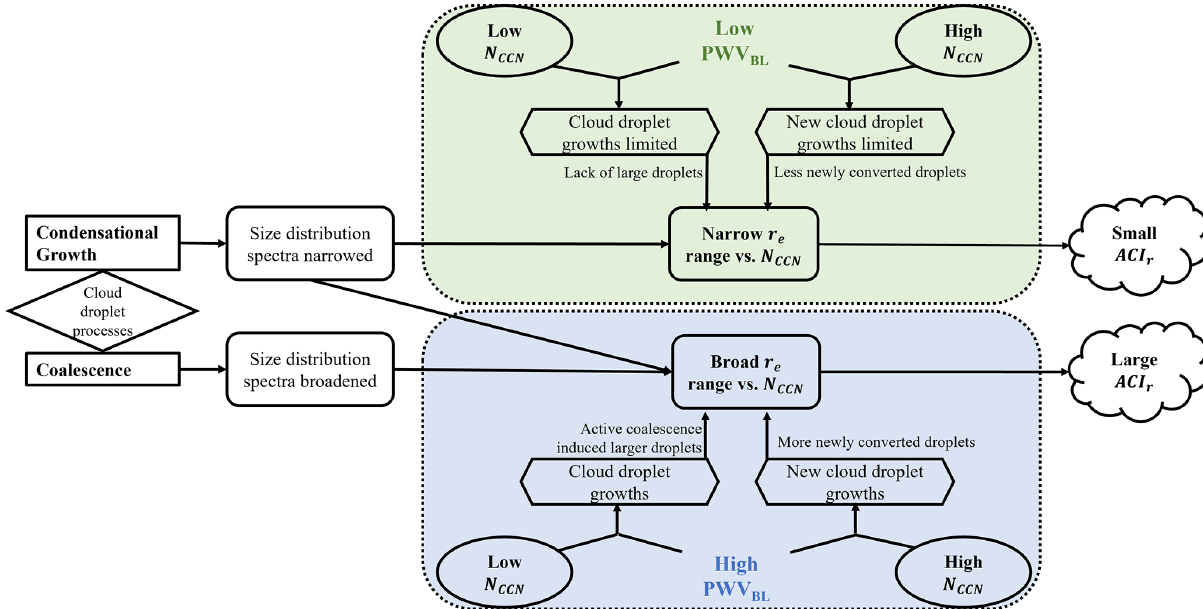
Figure 8. Theoretical mechanism of the responses of cloud droplet size distributions to different CCN intrusions, under relatively insufficient (low PWV BL ) versus sufficient (high PWV BL ) water vapor